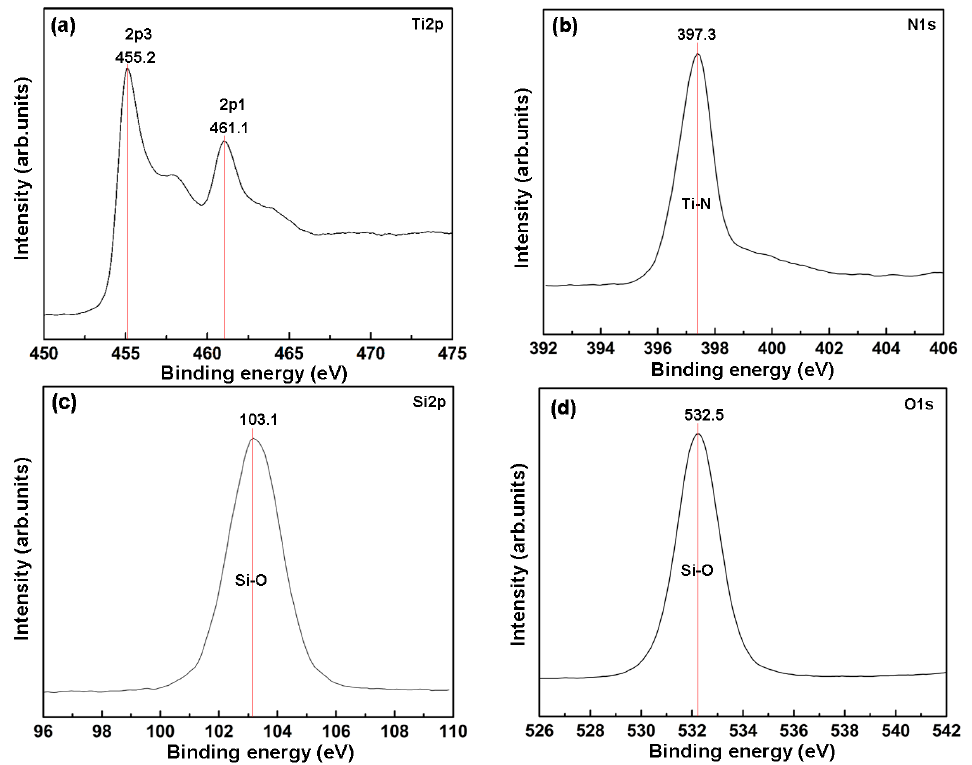
Figure 3. XPS spectrum of the TiN and SiO x component layers: ( a ) Ti2p; ( b ) N1s; ( c ) Si2p; ( d ) O1s.